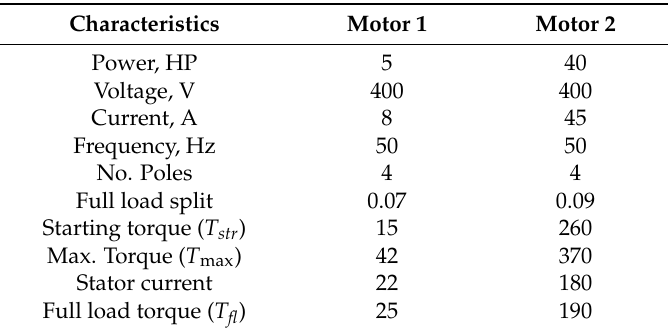
Table 1. Manufacturer’s motor data.